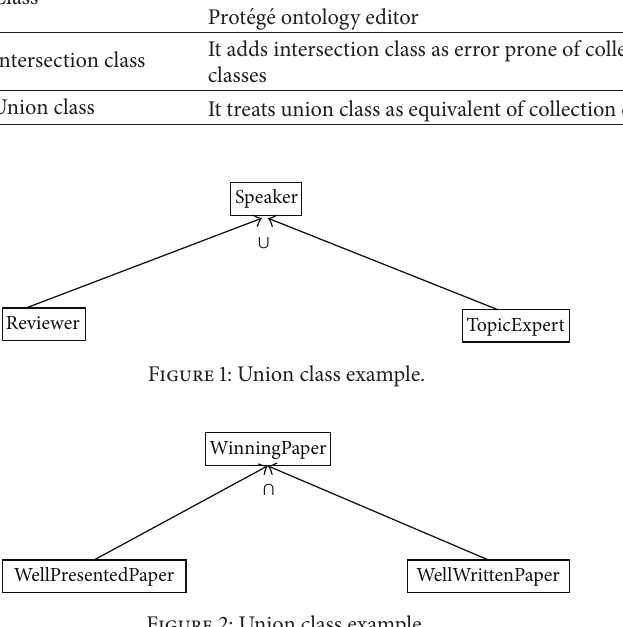
Figure 2: Union class